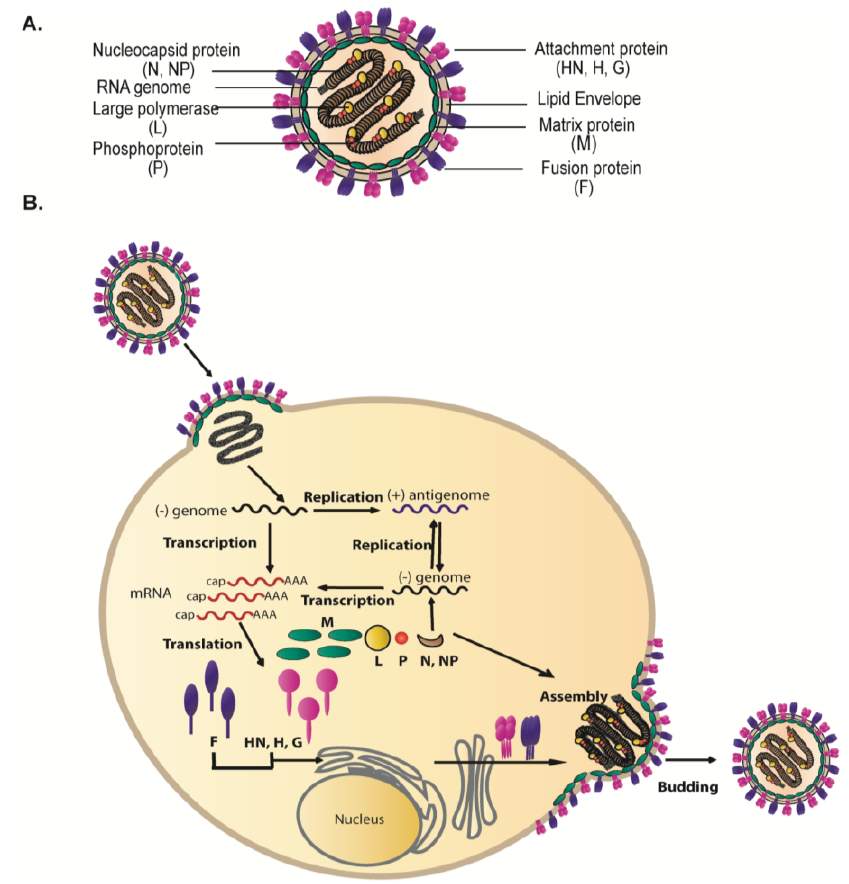
Figure 1. ( A ) Schematic of a paramyxovirus particle. The viral envelope, containing two main surface glycoproteins: fusion protein (purple) and attachment protein (magenta), surrounds the single stranded RNA genome (gray) which is encapsidated by the nucleocapsid protein (brown) and bound by phosphoprotein (orange) and the large polymerase protein (yellow). Underlying the membrane is a layer of matrix proteins (green). ( B ) Schematic illustration of the life cycle of paramyxoviruses. Transcription and replication of the viral genome occurs in the cytoplasm by the action of the viral RNA-dependent RNA polymerase. The newly synthesized viral components translocate to discrete sites at the infected cell plasma membrane where assembly and budding of infectious virus particles occur. For details, refer to